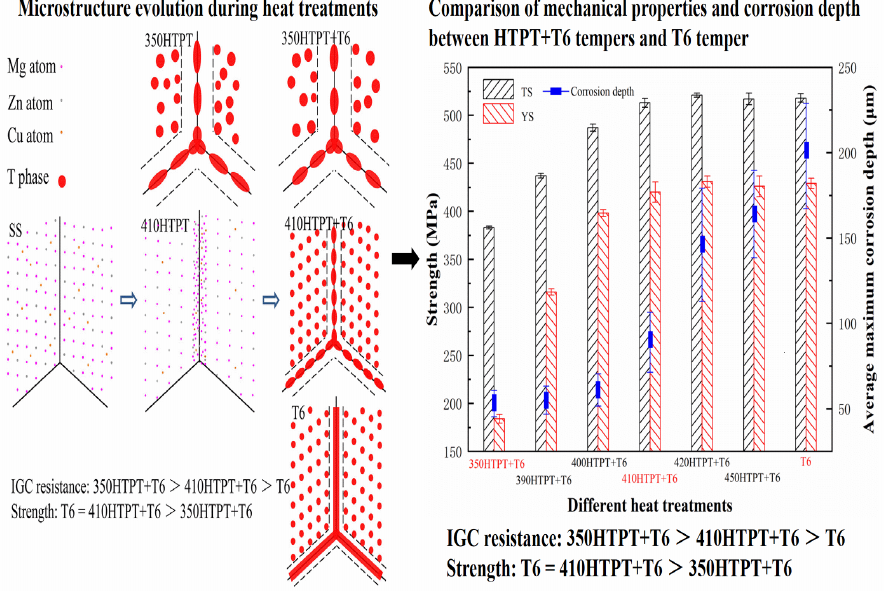
Figure 12. Mechanical properties, corrosion depth, and microstructure evolution of Al-5.16Mg- 3.12Zn-0.15Cu alloys after various treatments [44].